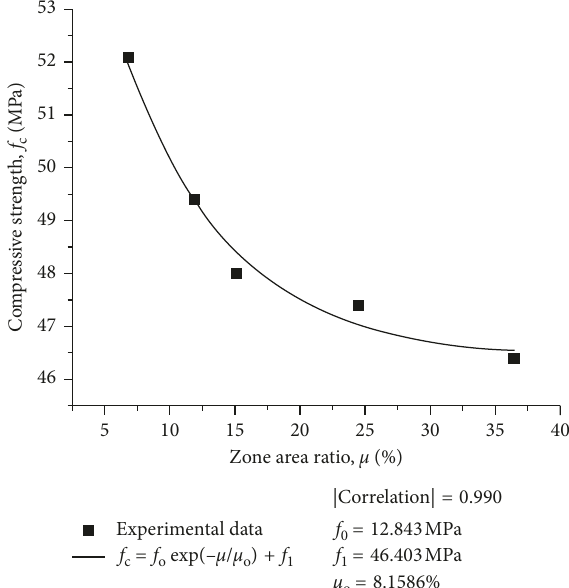
Figure 11: The decreasing sequence of compressive strength of cement mortar in dependence on zone area ratio. The experimental data are identical to those shown in Figures 7–9.